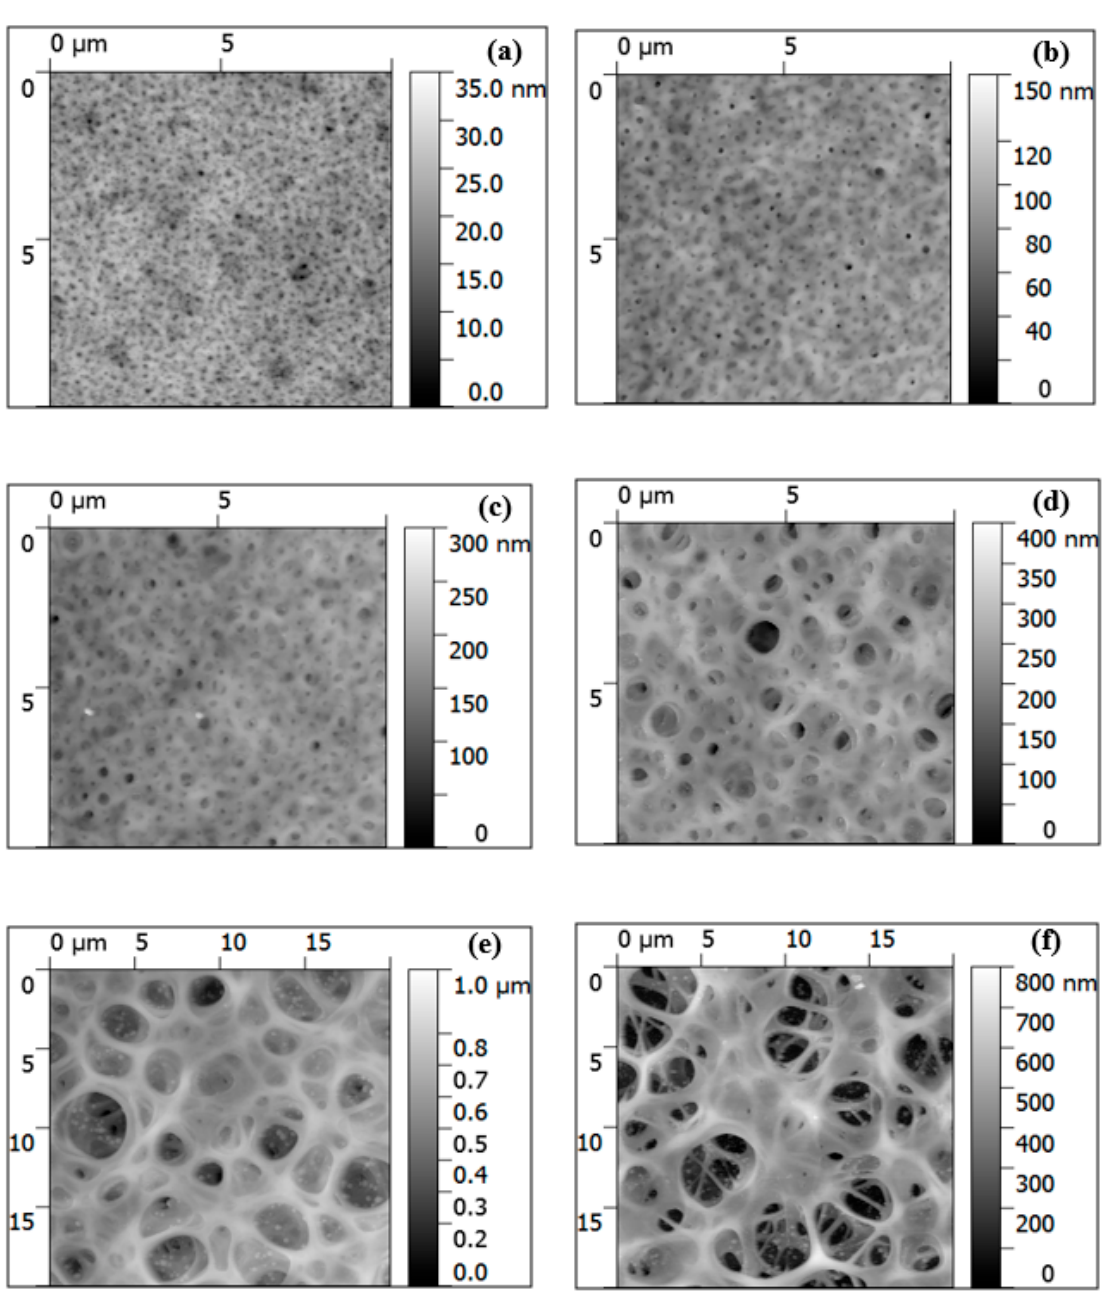
Figure 5. AFM topographical images of the carbonized polymer films obtained from ( a ) PAN/PET-10-25, ( b ) PAN/PET-20-25, ( c ) PAN/PET-25-25, ( d ) PAN/PET-30-25, ( e ) PAN/PET-35-25, and ( f ) PAN/PET-40-25. The scale bar on the right side of the AFM images depicts the height scale of the image, where light and dark shades correspond to high and low relative heights, respectively.